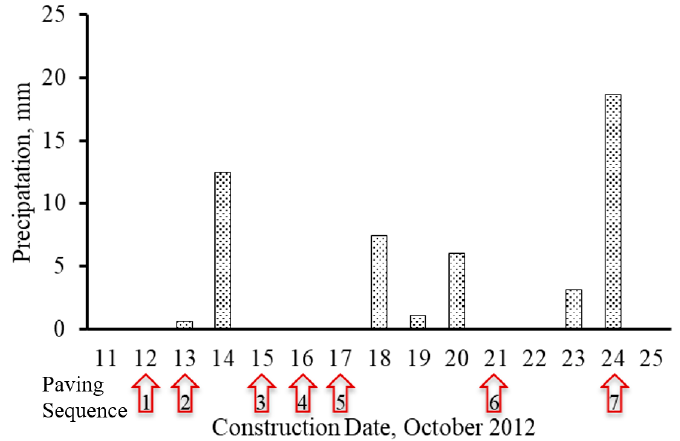
Figure 9. Comparison of daily precipitations to paving dates.